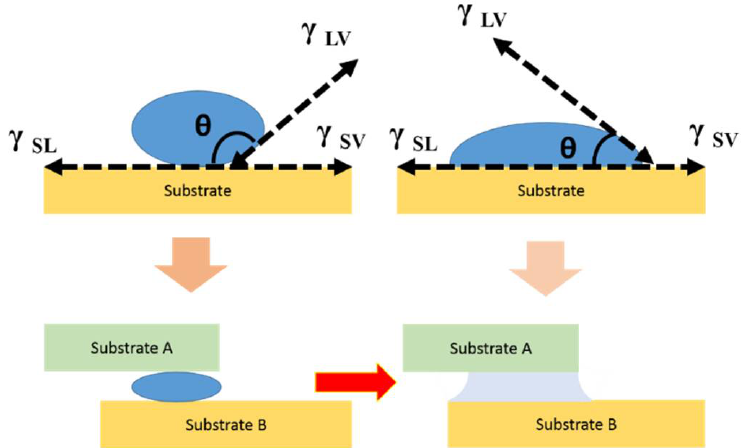
Figure 2. Schematic of wettability of filler on contact substrates. When ϴ > 90°, wetting is insufficient; when ϴ < 90°, wetting is sufficient. The cross-section of lap joints between two substrates is also shown at the bottom.